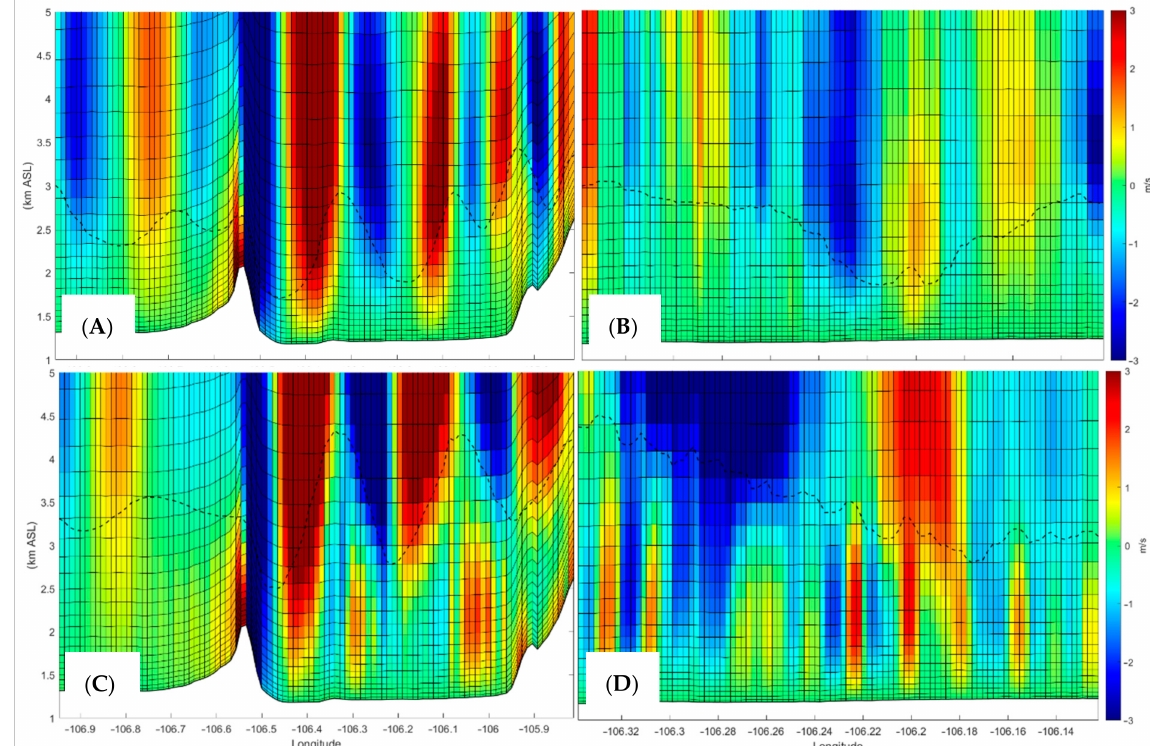
Figure 9. WRF w velocity and BL depth (dashed line) vertical cross-sections, 17 April 2018. ( A ) 1700 UTC, parallel to the flow. Propagating lee waves modulate the BL. ( B ) 1700 UTC, perpendicular to the flow. Stable stratification suppresses w below the BL. ( C ) 2100 UTC, parallel to the flow. Lee waves shift from propagating to trapped while intense bursts of w are present within the BL. ( D ) 2100 UTC, perpendicular to the flow. Several LRS are observed below the BL that propagate lateral to the